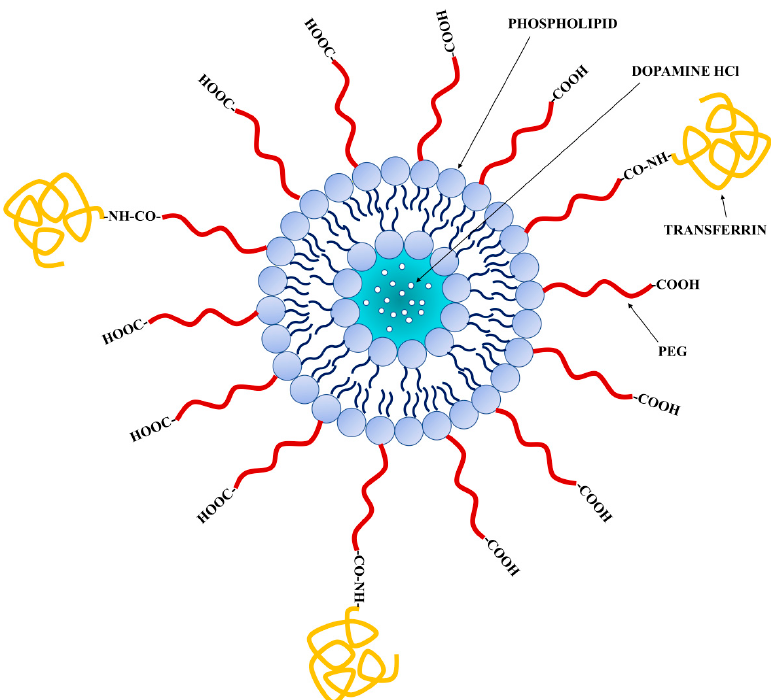
Figure 1. Schematic representation of functionalized DA ∙ HCl-LPs. LPs are made of a phospholipid bilayer, which encloses an aqueous center. The aqueous space incorporates the hydrophilic DA ∙ HCl. Hydrophilic polymer polyethylene glycol (PEG) coats the ligand-targeted LPs.